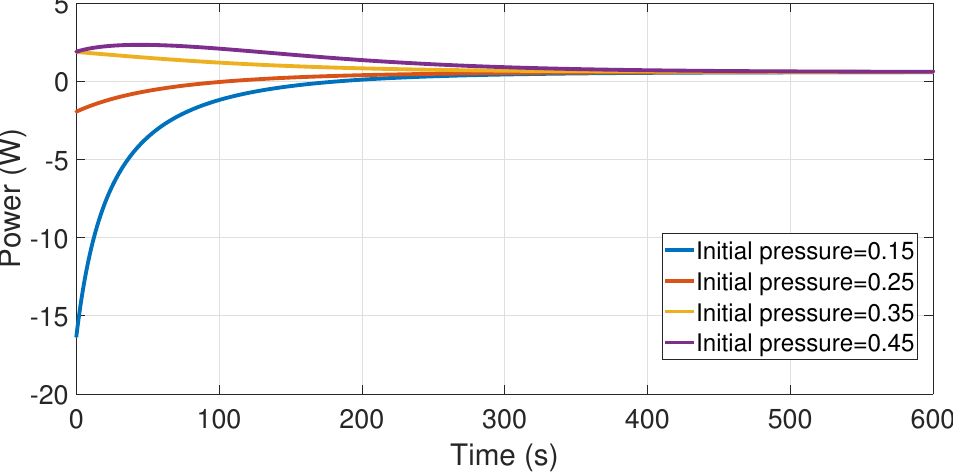
Figure 9. Simulation of power stability with different values θ 0